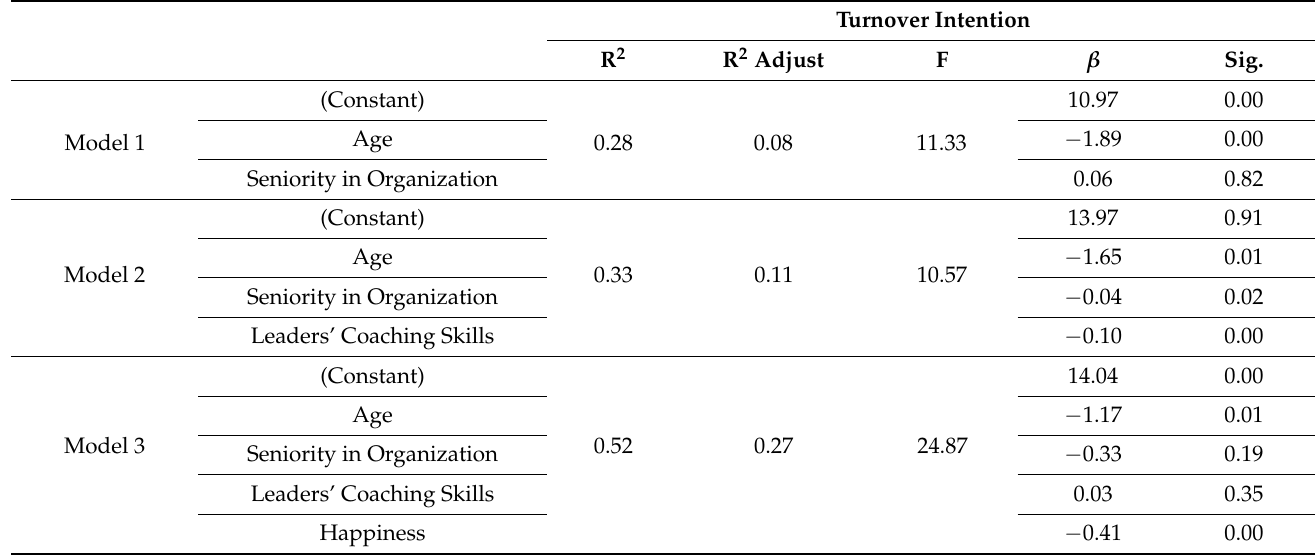
Table 5. Regression of the predictor variable on the criteria to control the mediator. How Happiness mediates effect of Leaders’ Coaching Skills on Turnover